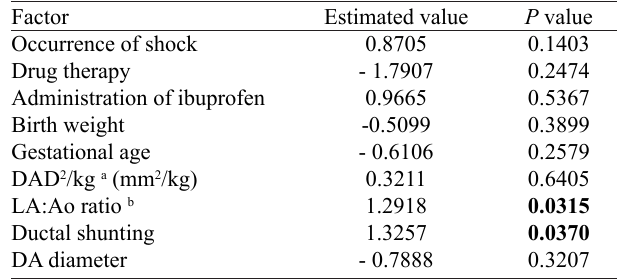
Table 4. Probability of surgical closure in preterm neonates with patent ductus arteriosus considering the combined factors left atrial-to-aortic root diameter ratio (LA:Ao) and